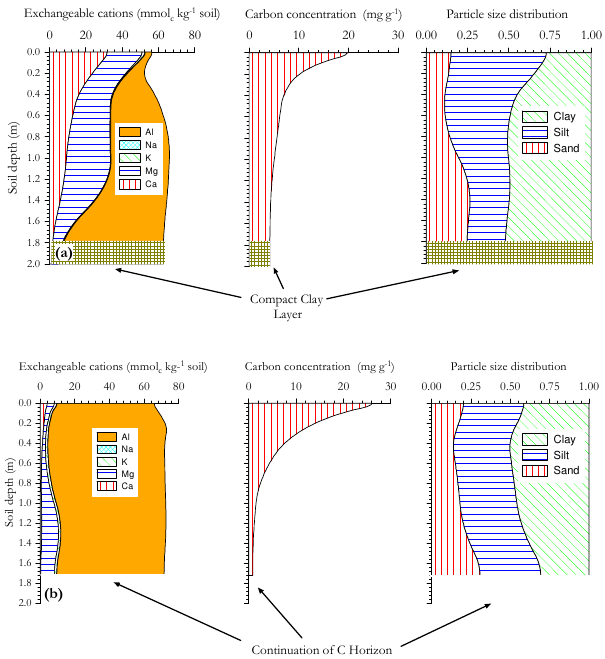
Fig. 8 Fig. 8. Profiles of exchangeable cations, soil carbon and tex- ture: (a) for a Haplic Plinthosol (Alumic, Orthodystric, Siltic), at Acre state, Brazil (DOI–02) and (b) for an Endostagnic Plinthosol (Alumic, Hyperdystric) in Colombia